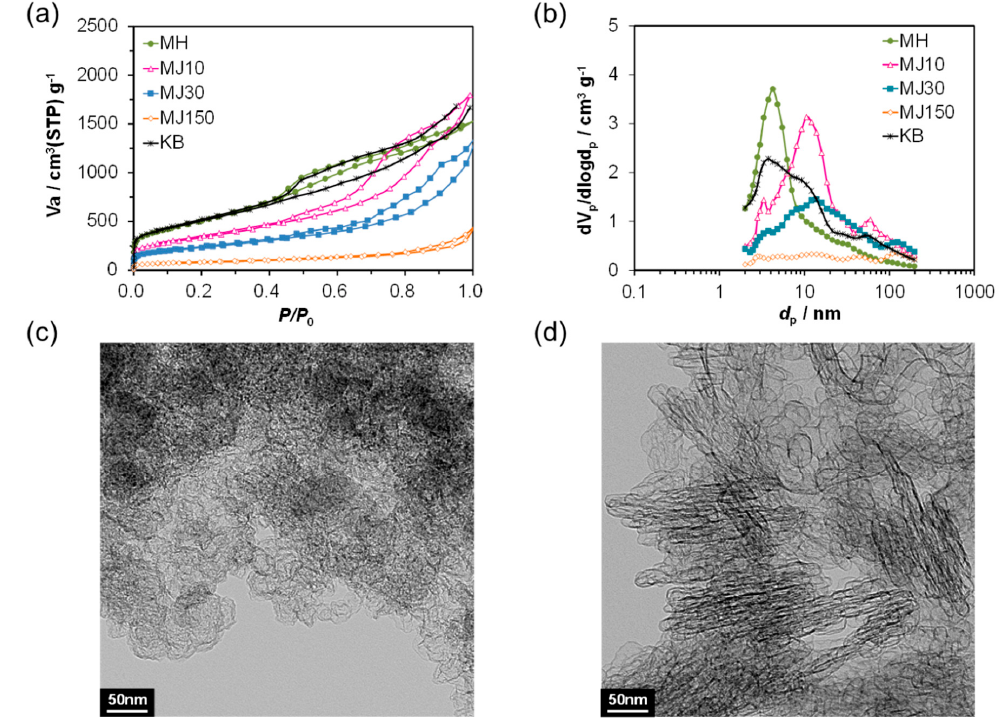
Figure 2. Characterization of KB, MH, MJ10, MJ30, and MJ150: ( a ) Nitrogen adsorption / desorption isotherms at − 196 °C and ( b ) Barrett–Joyner–Halenda (BJH) pore size distributions. Transmission electron microscopy (TEM) micrographs of ( c ) KB and ( d ) MJ10.